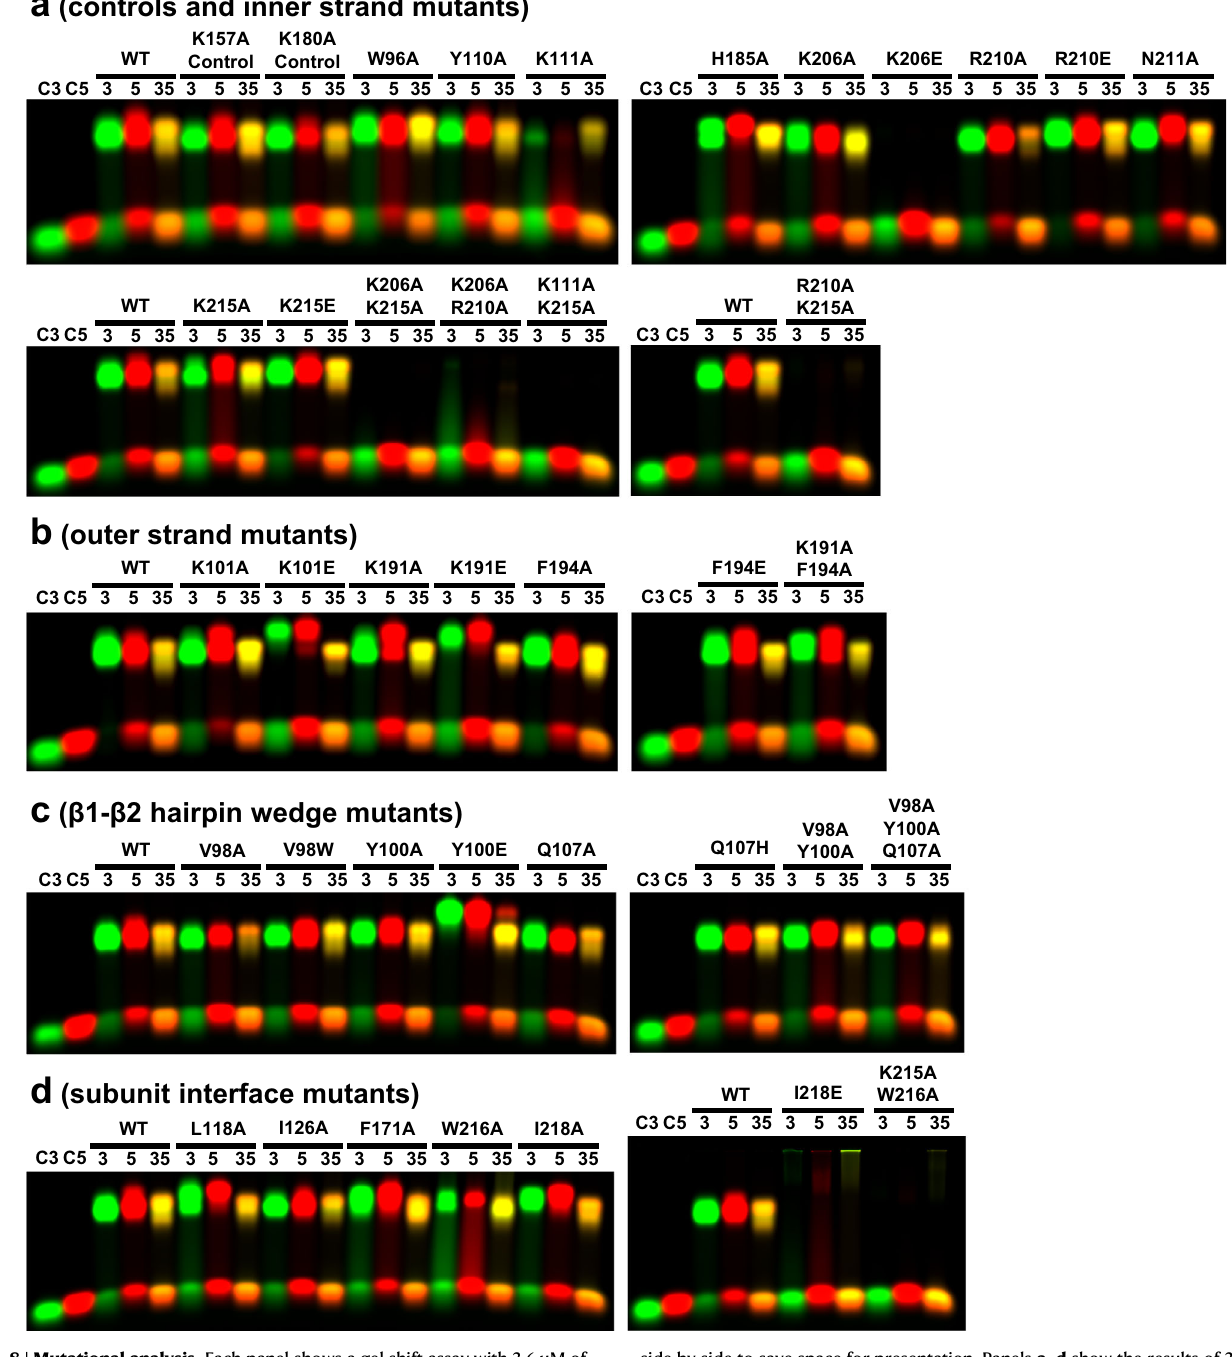
side by side to save space for presentation. Panels a – d show the results of 39 different variants grouped according to their location in the structure, as shown structurallyinFig.7.AtleastoneWTisshownforeachpairofgelstoallowfordirect comparison. All gel images were obtained with the same scanning conditions and no furtheradjustments to contrast.Although only one gel is shown for eachgroup ofproteinvariants,eachexperimentwasperformedmultipletimes(atleasttwice), with very similar results. Source data are provided as a Source Data